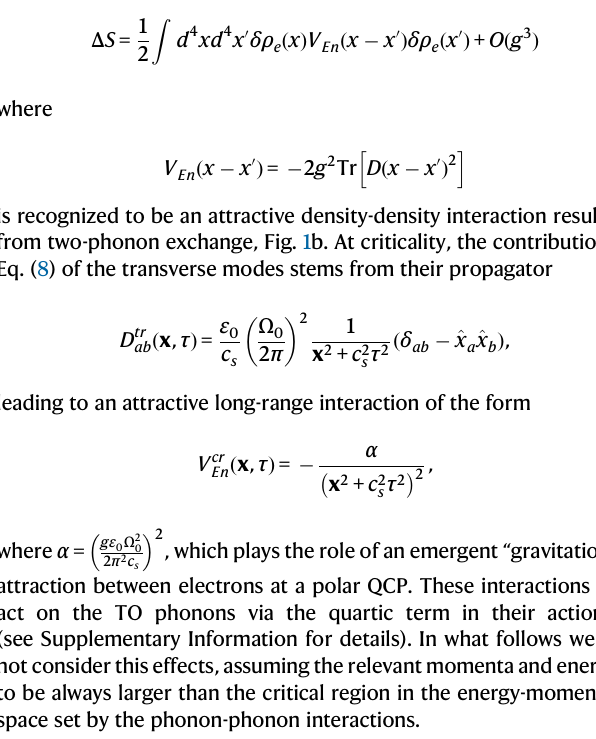
ð ω T 0 Þ 3 theinteractioncanbe 2 c s 3 π 2 3 Þ ,